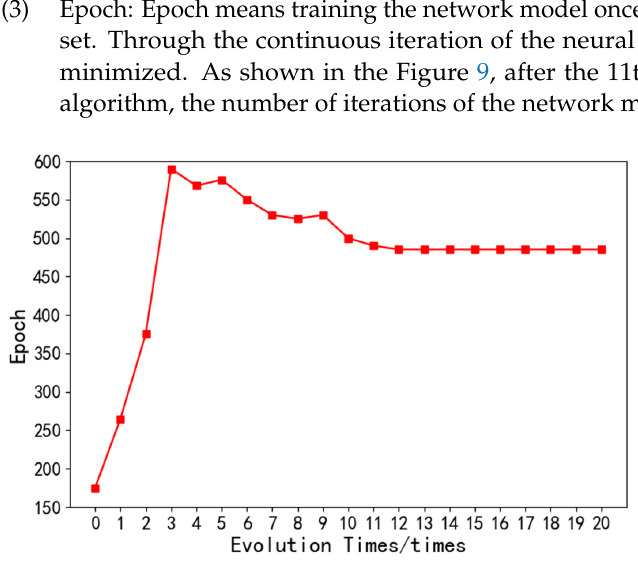
Figure 9. The epoch of neural